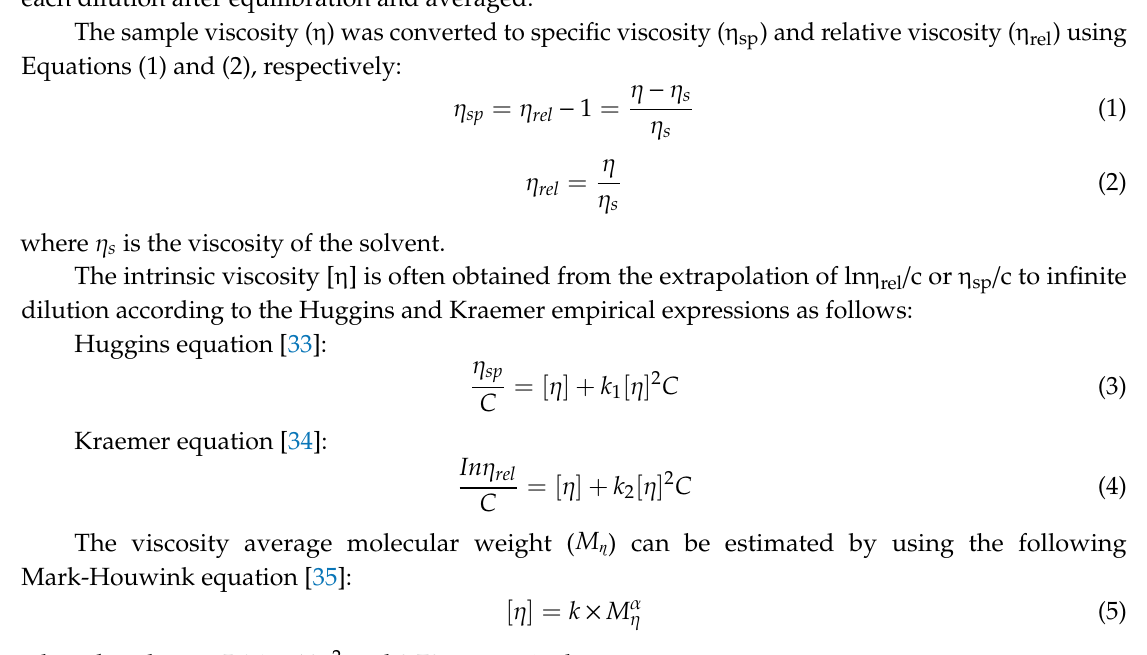
Figure 1. The chemical structure of konjac